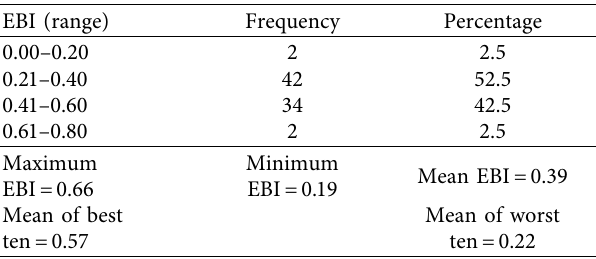
Table 3: Overall entrepreneurial behavioral index (EBI) of respondents.